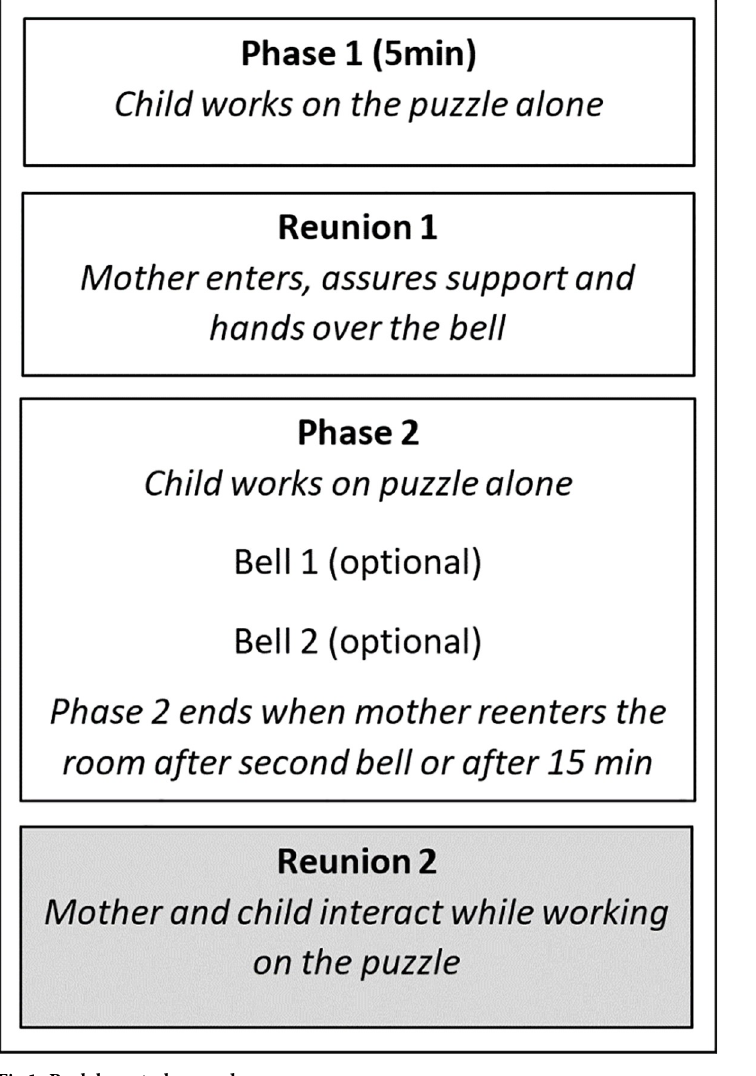
Fig 1. Rush hour task